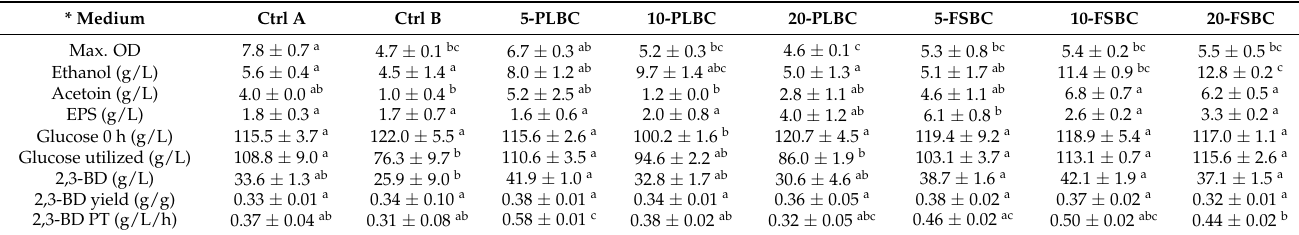
Table 5. Fermentation parameters of P. polymyxa grown in Group B media containing ~115 g/L